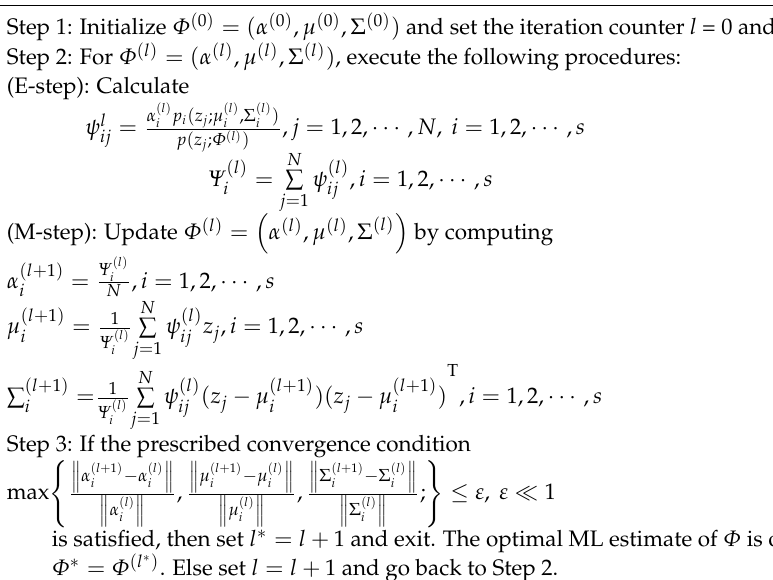
Algorithm 1 . The Execution Process of the EM